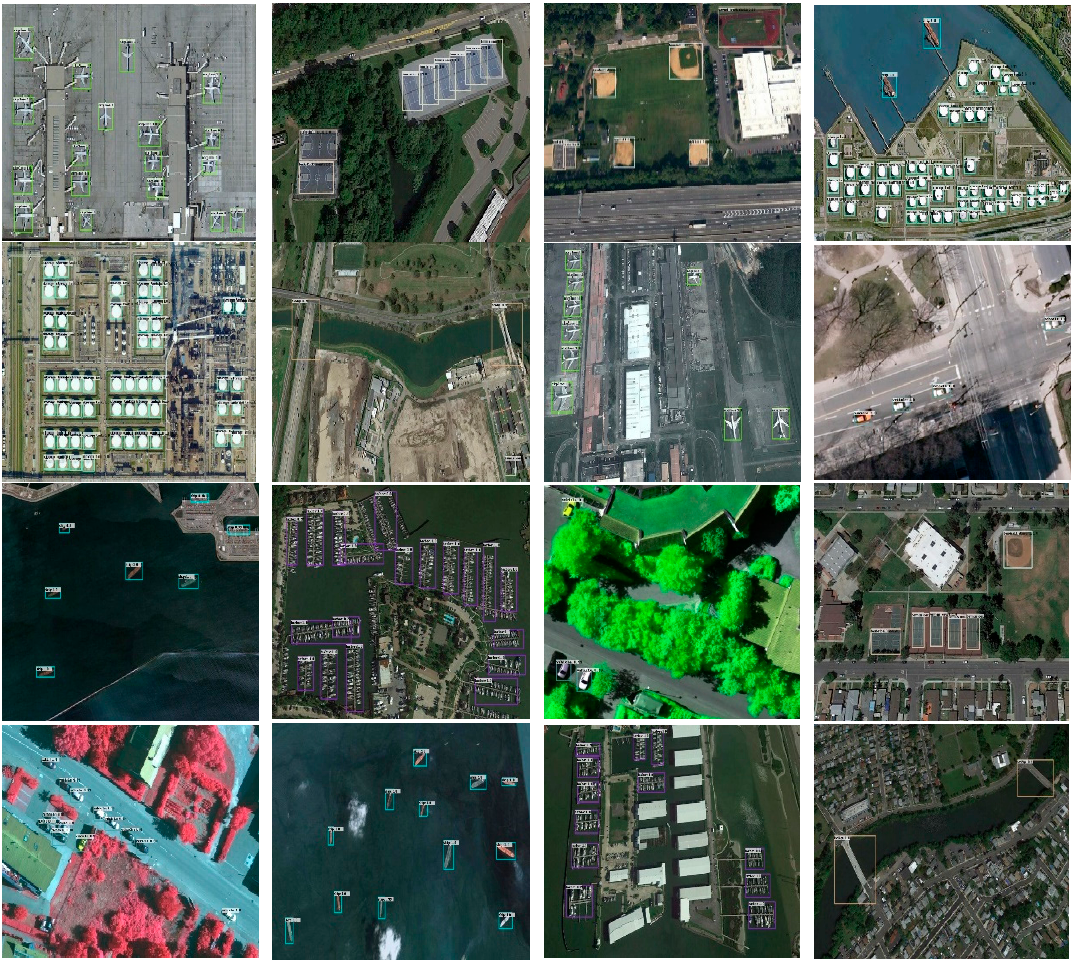
Figure 12. Detection results of our model SD-MS, which used ten classes of the NWPU VHR-10 dataset to test the results. Table 4. The AP values of eight object detections are compared with the two models, feature pyramid networks with multi-scale anchor (FPN + MS) and shallow-deep feature extraction with multi-scale anchor